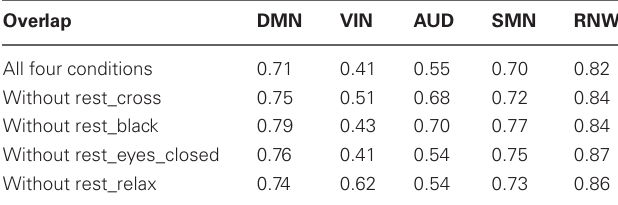
Table 2 | Overlap at the group level for all four conditions compared to the overlap of any possible combination of three